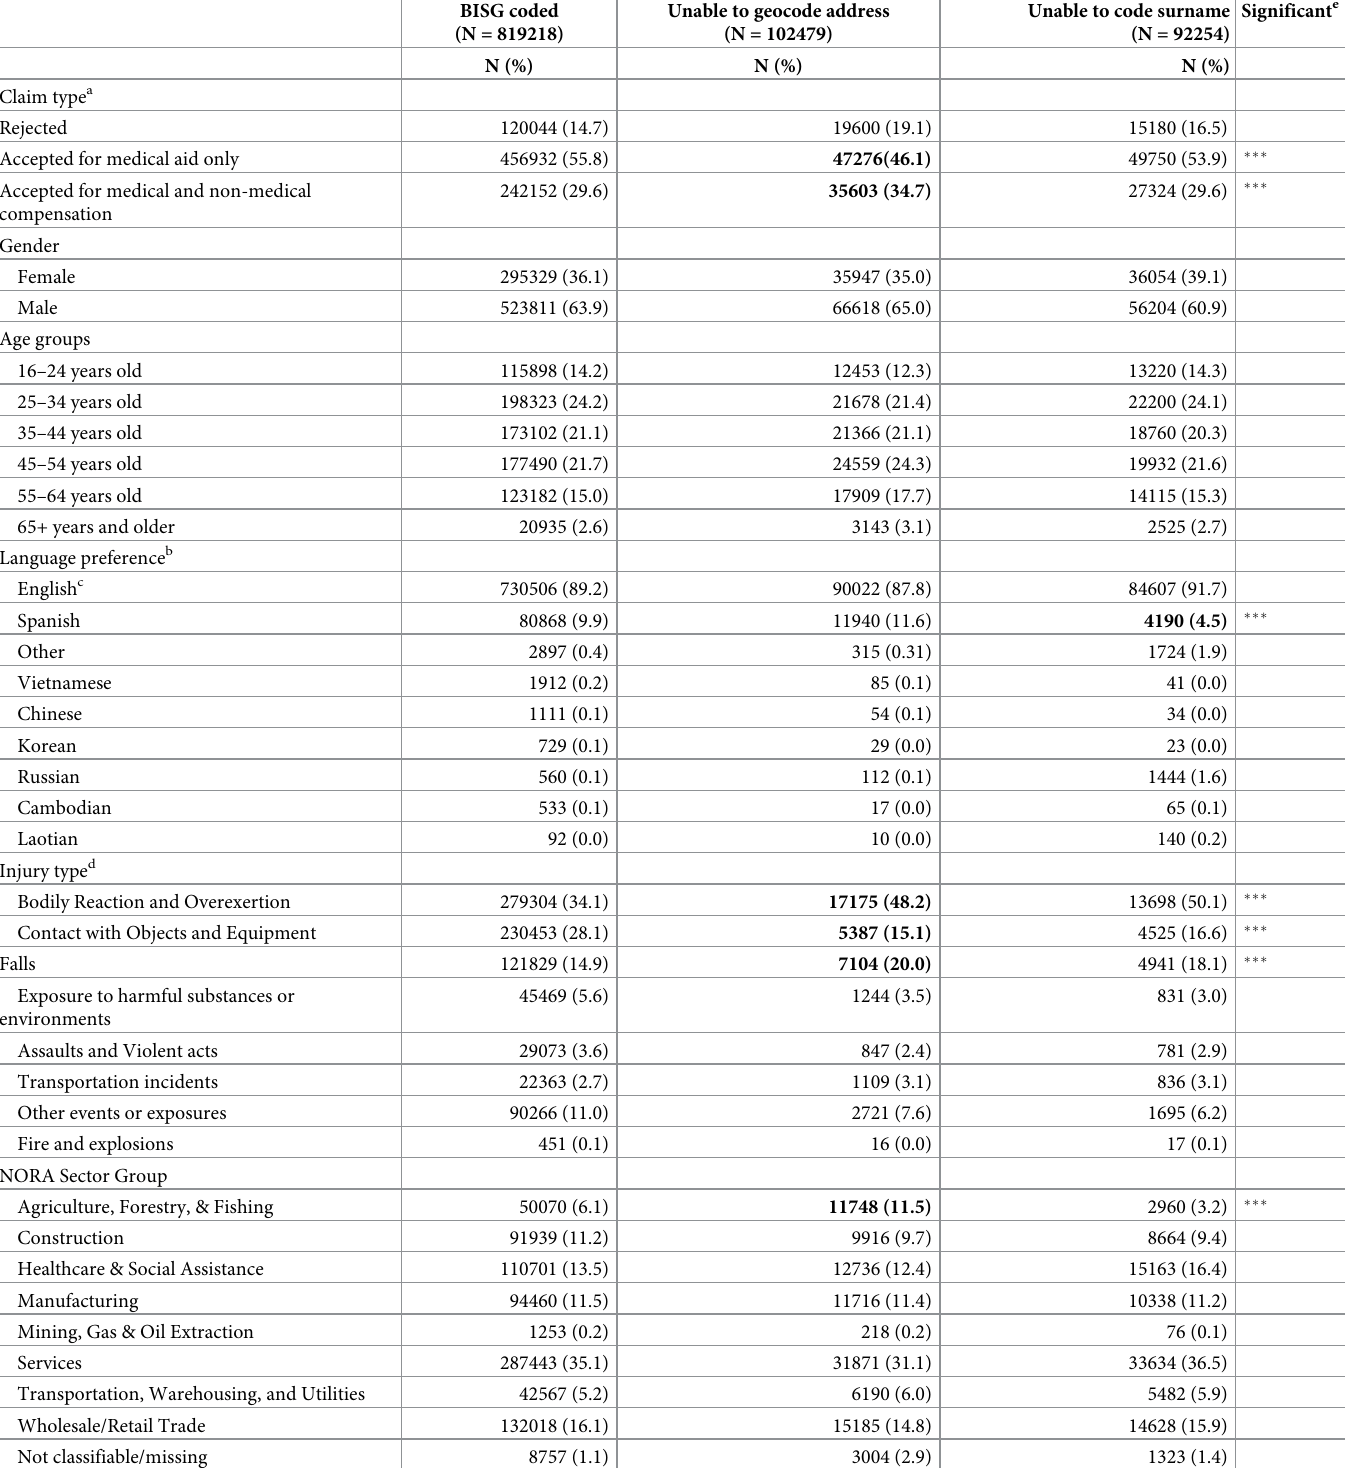
Table 4. Differences in characteristics between the coded BISG sample, and those not coded due to missing or non-specific physical address and those with less common